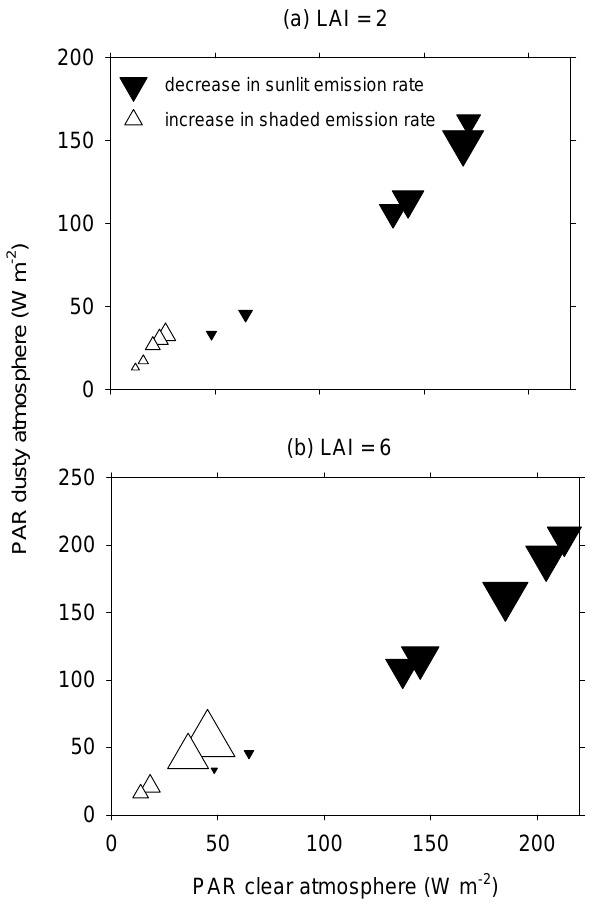
Fig. 8. Changes in isoprene emission rate plotted with respect to the relevant PAR in clear and dusty atmosphere for ( a ) LAI=2 and ( b ) LAI=6. For sunlit emissions, we plot sunlit PAR in dusty atmo- sphere against sunlit PAR in clear atmosphere, and similarly shaded PAR is used for shaded emissions. The size of the points indicates the magnitude of the change in emission rate going from clear to dusty atmosphere and the orientation of the triangles indicates in- crease (upward pointing) or decrease (downward pointing) in emis- sion rate. The scale of the emission rate changes are from − 0 . 04 to − 0 . 14mgCm − 2 h − 1 for sunlit and 0.02 to 0.06mgCm − 2 h − 1 for shaded in (a) . The scale is the same for (b) .